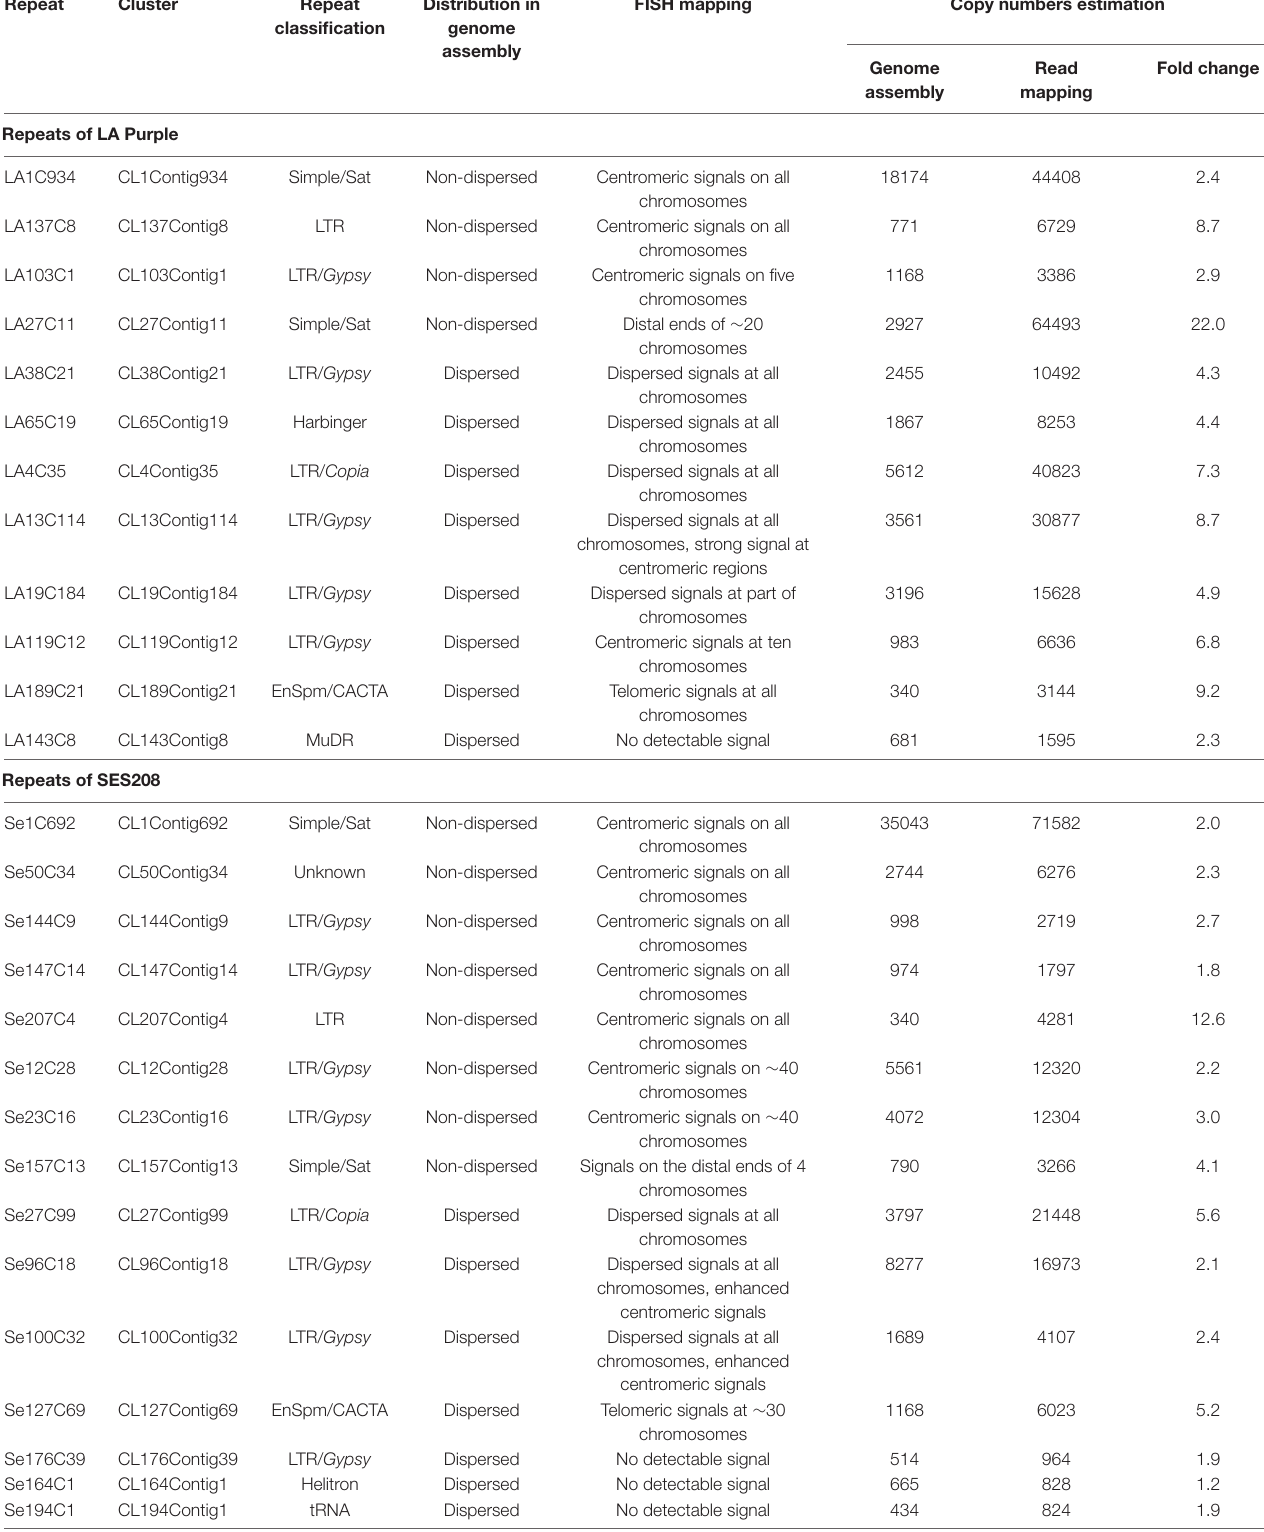
TABLE 1 | Summary of repetitive sequences in LA Purple and SES208 a .